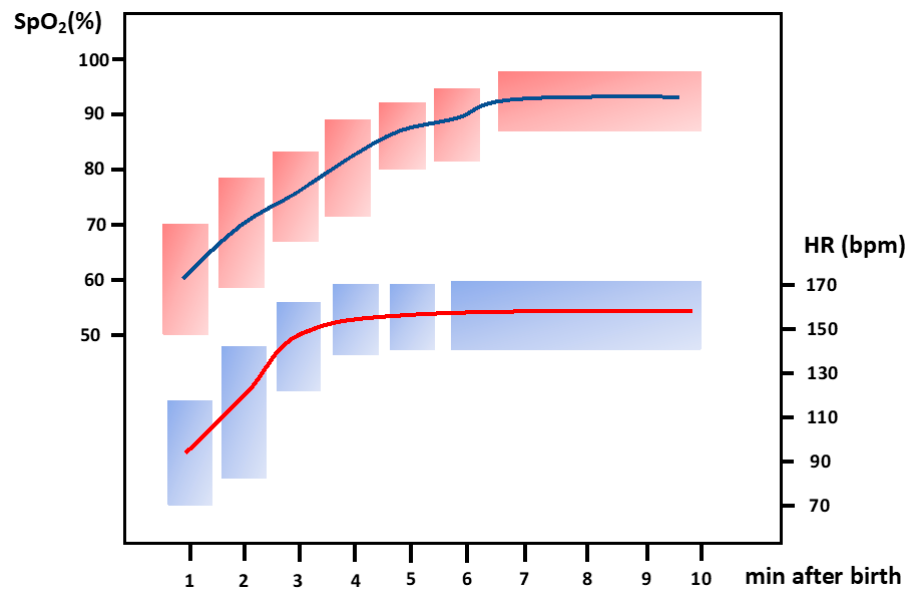
Figure 3. Oxygen saturation (SpO 2 ) according to AHA guidelines should be targeted at 70–75% at 3 min and 80–85 at 5 min. Heart rate (HR) should be targeted at >100 bpm in the first 2–3 min after birth. Red and blue rectangles define the normality ranges for SPO 2 and HR, respectively, at different postnatal timings after birth (Graph modified from reference [28]). Red and blue rectangles define the upper and lower of normality ranges for SPO 2 and HR, respectively, minute-by-minute in the first 10 min of